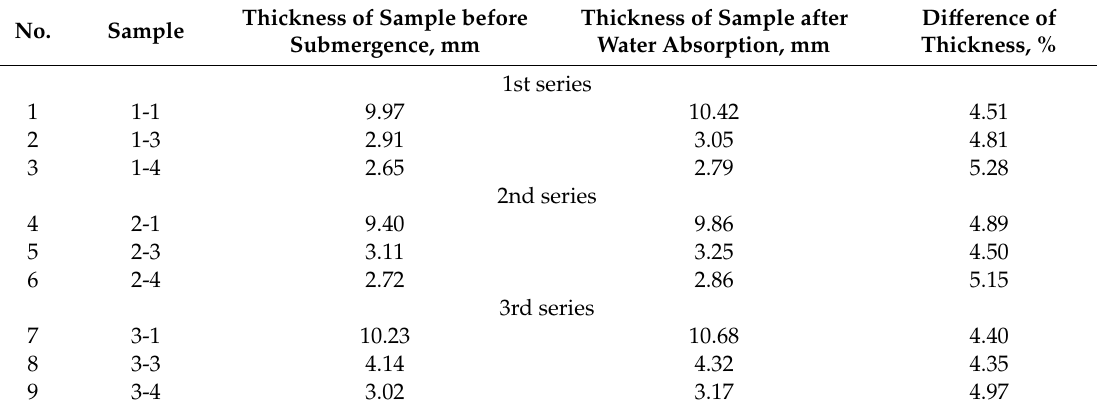
Table 7. Di ff erence of the thickness for dry and water-absorbed hemp